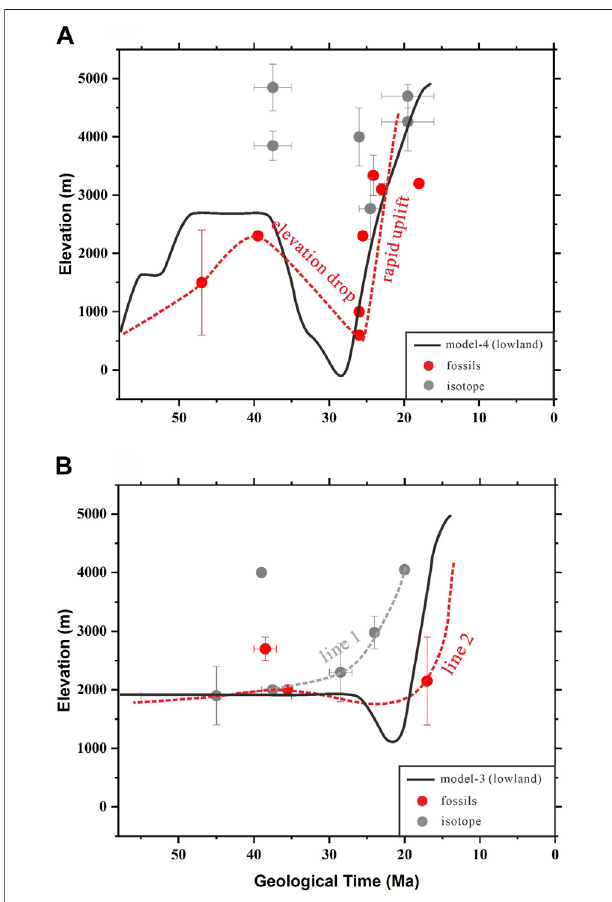
FIGURE13| CompilationofpaleolevationsdataoftheLunpolaBasin (A) Red circles are the paleoelevations of the Lunpola Basin obtained from fossils of plant, animal, and pollen (Deng et al., 2011; Sun et al., 2014; Wu et al., 2017; Liu et al., 2019; Farnsworth et al., 2018, Su et al., 2020; Fang et al., 2020; and Xie et al., 2021). Gray circles represent the paleoelevations based on the oxygen isotope (Polissar et al., 2009; Jia et al., 2015) and hydrogen isotope (Rowley and Currie, 2006; Fang et al., 2020). The red dashed curvedraws theexpected uplifthistory oftheLunpolaBasinbasedon fossils. The black curve displays the uplift history of the lowland center in model-4 (B) Red circles are the paleoelevations of the Hoh Xil Basin obtained fromfossils(Sunetal.,2015;Miaoetal.,2016;Songetal.,2021).Graycircles represent the paleoelevations based on the oxygen isotope (Cyr et al., 2005; Quade et al., 2011; Li et al., 2020) and the hydrogen isotope (Polissar et al., 2009). Dashed curves depict the expected uplift histories of the two sub- basins in the Hoh Xil Basin based on paleoelevations. The black curve shows the tendency of the uplift history of the lowland center in model-3.